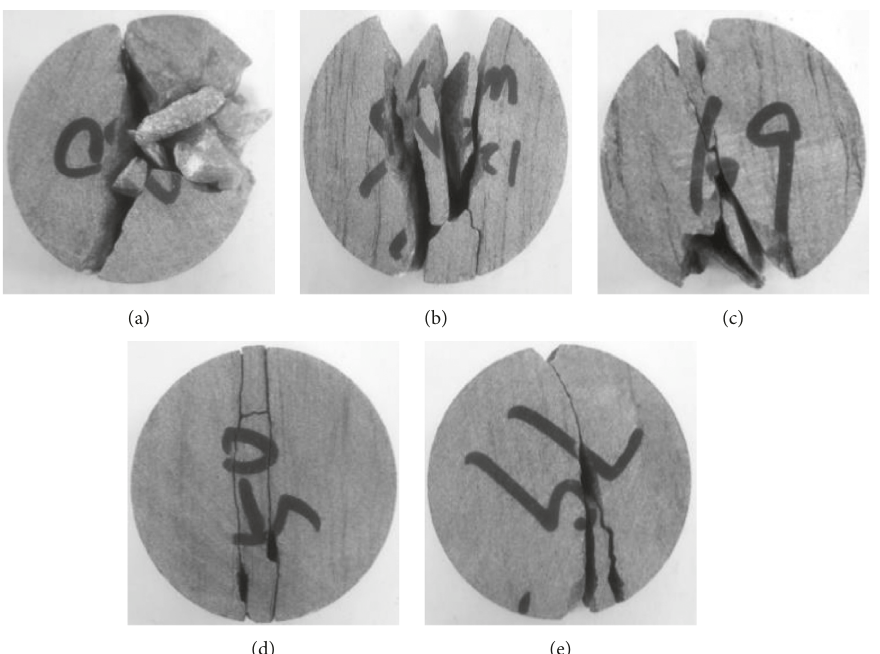
Figure 8: Failure of specimens with different water contents at a strain rate of 53.04 s − 1 : (a) ω � 0.31%; (b) ω � 0.54%; (c) ω � 0.71%; (d) ω � 0.93%; (e) ω � 1.09%.